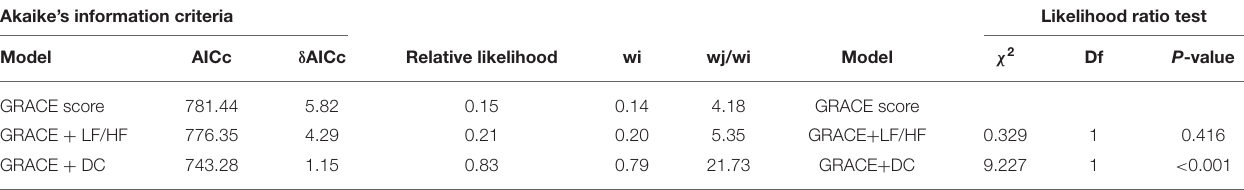
TABLE 5 | Akaike’s information criteria and likelihood ratio test to determine the best fitting model for prediction MACEs. Akaike’s information criteria